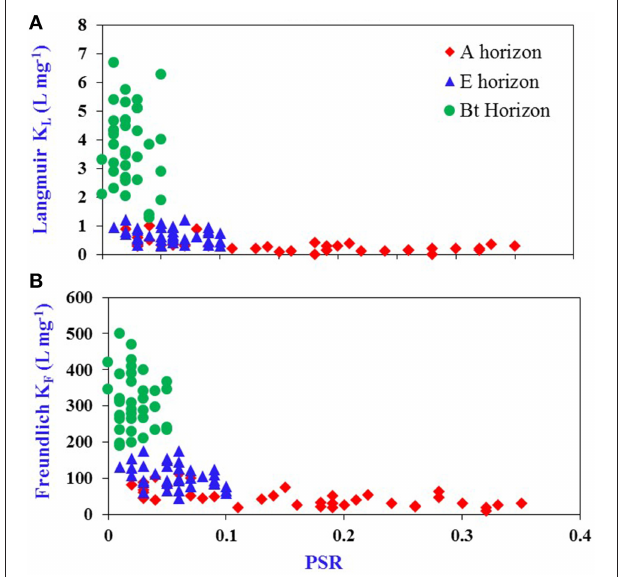
FIGURE 2 | Relationship between: (A) K L and P saturation ratio (PSR) calculated using P, Fe, and Al in an oxalate extract and (B) K F and PSR for A, E, and Bt horizons of Ultisols/Entisols/Alfisols ( n = 108